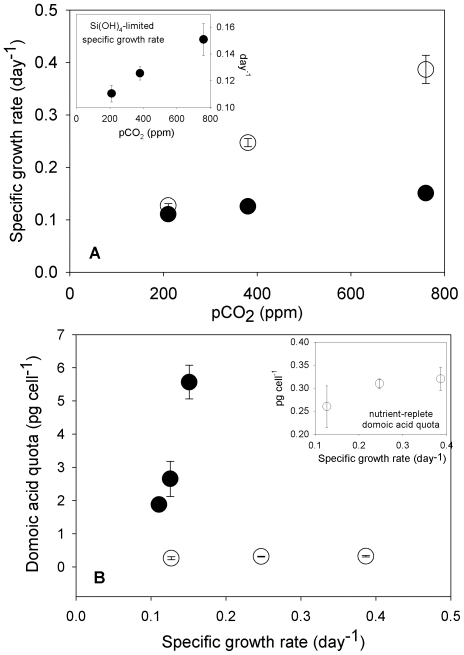
Relationships between nutrient-limited growth rates, pCO2, and toxicity in Pseudo-nitzschia fraudulenta.Specific growth rates (day−1) versus pCO2 (a) and cellular domoic acid quota (pg cell−1) versus specific growth rates (b) under Si(OH)4-limited (•) and nutrient-replete (○) conditions at three seawater CO2 concentrations (200, 360 and 765 ppm). Panel insets present the Si(OH)4-limited (a) or nutrient-replete (b) data with an expanded Y-axis scale for clarity. Error bars represent standard deviations of triplicates for each treatment.